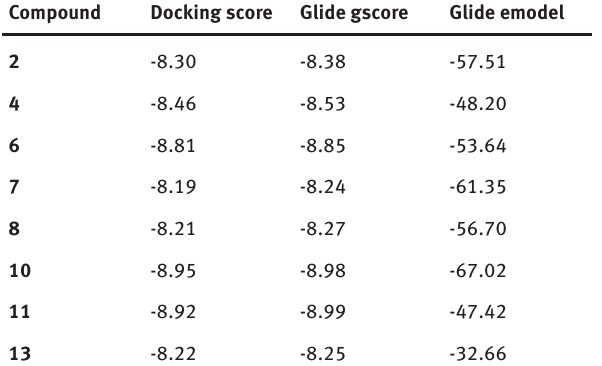
Table 3: Docking score (kcal/mol), glide gscore (kcal/mol) and glide emodel (kcal/mol) results of compounds 2 , 4 , 6 , 7 , 8 , 10 , 11 and 13 for Ae SCP2 (PDB code: